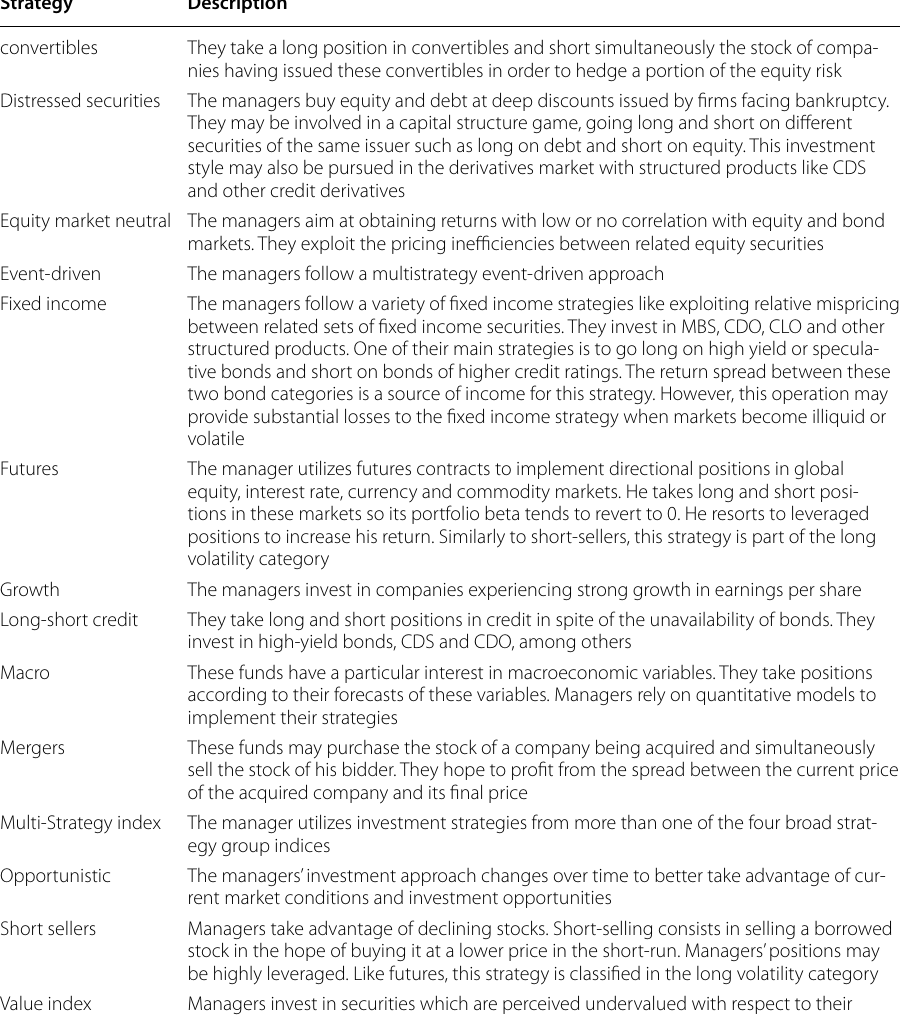
Table 1 Description of hedge fund